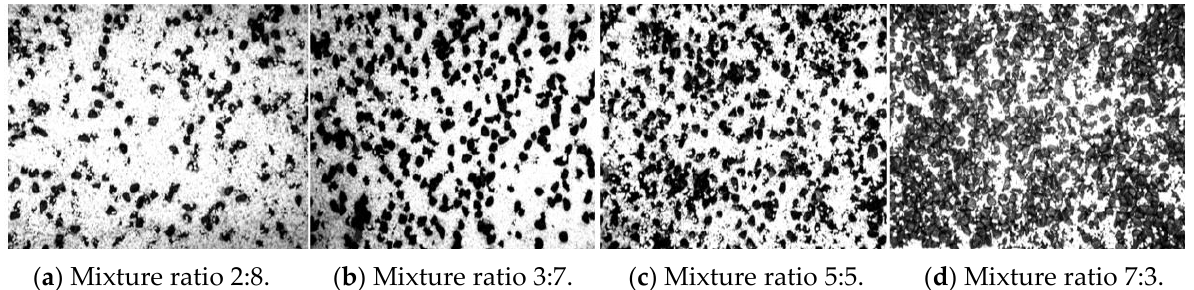
Figure 3. Several samples of bimodal non-uniform sands. Mixture ratio means the mass ratio of coarse sediments to fine particles in sediment mixture. The four pictures above indicate that the sands non-uniformities of different mixture ratios vary a lot. The size difference between coarse and fine particles is medium, which means that the size of fine particles in the mixture is still significant enough to have an effect on coarse particles and promote their incipient motion. Coarse particles and fine particles have interactive potential in starting moving process.